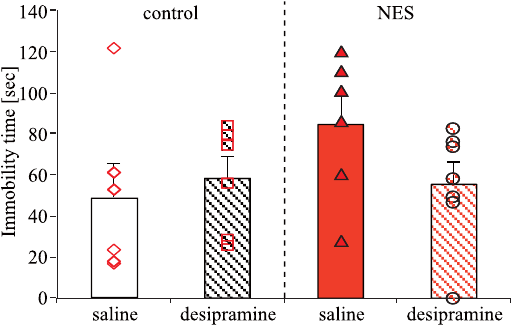
Figure 8. Effect of desipramine on FST immobility time induced by NES feeding condition (Experiment 7). The FST immobility time at ZT 1 after keeping mice to each feeding condition for 4 weeks. Each plot depicts individual data. Mice under each feeding condition were injected with saline or desipramine 30 min before the FST. Data are presented as the mean ± SEM (n =